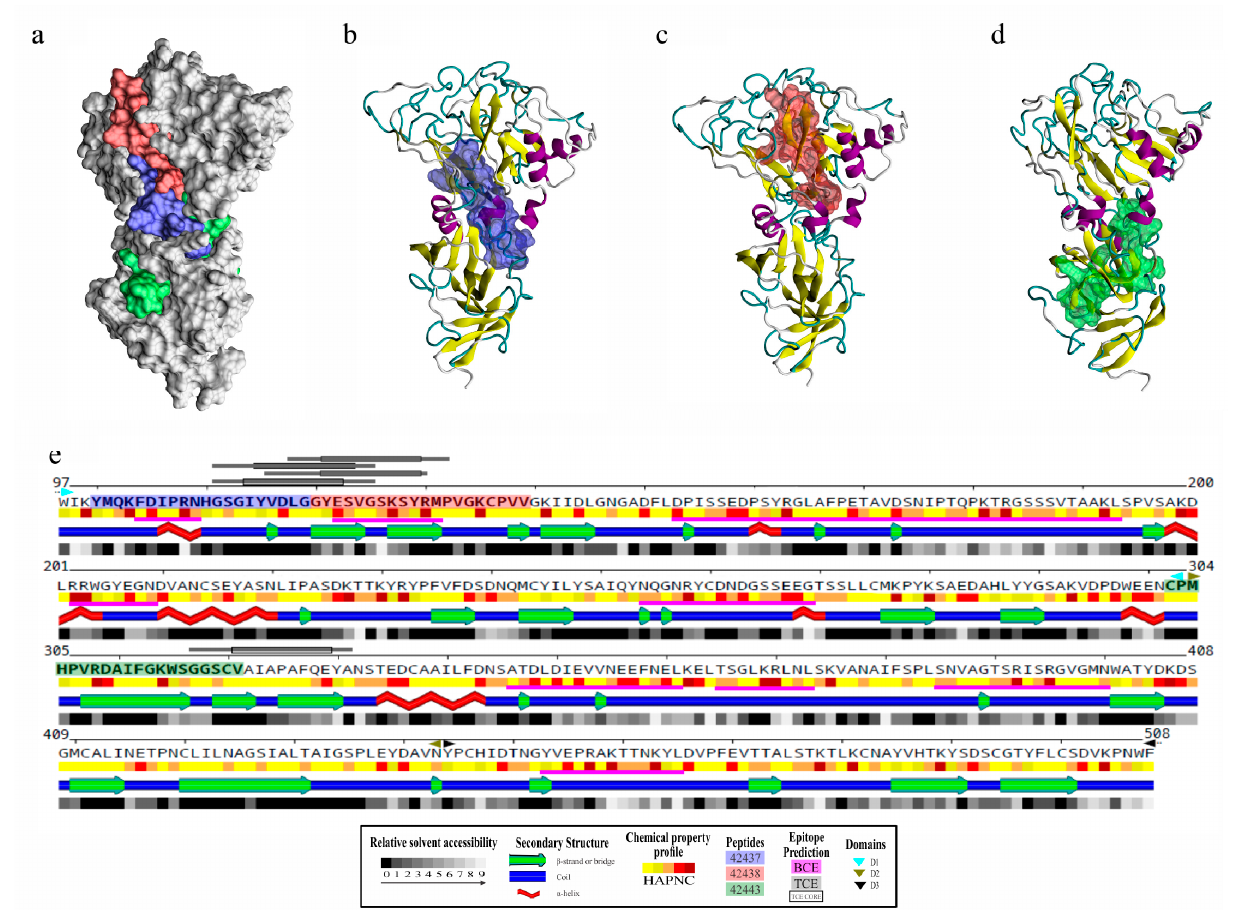
Figure 3. Structural analysis and B- and T-cell epitope prediction for B. bovis AMA-1-DI-II. ( a ) Localisation on the surface view of HABPs 42437 (blue), 42438 (red), and 42443 (green). Peptides 42437 ( b ) and 42438 ( c ) had more surface-accessible residues than peptide 42443 ( d ). ( e ) Secondary structure representation, including the relative solvent accessibility and physical-chemical amino acid profile. Peptide sequences are presented in bold and boxed using the same color code as in panel a. DI (cyan triangles), DII (green triangles), and DIII (black triangles) are also indicated. Regions containing B-cell epitopes are highlighted by magenta bars and T-cell ones by grey bars.